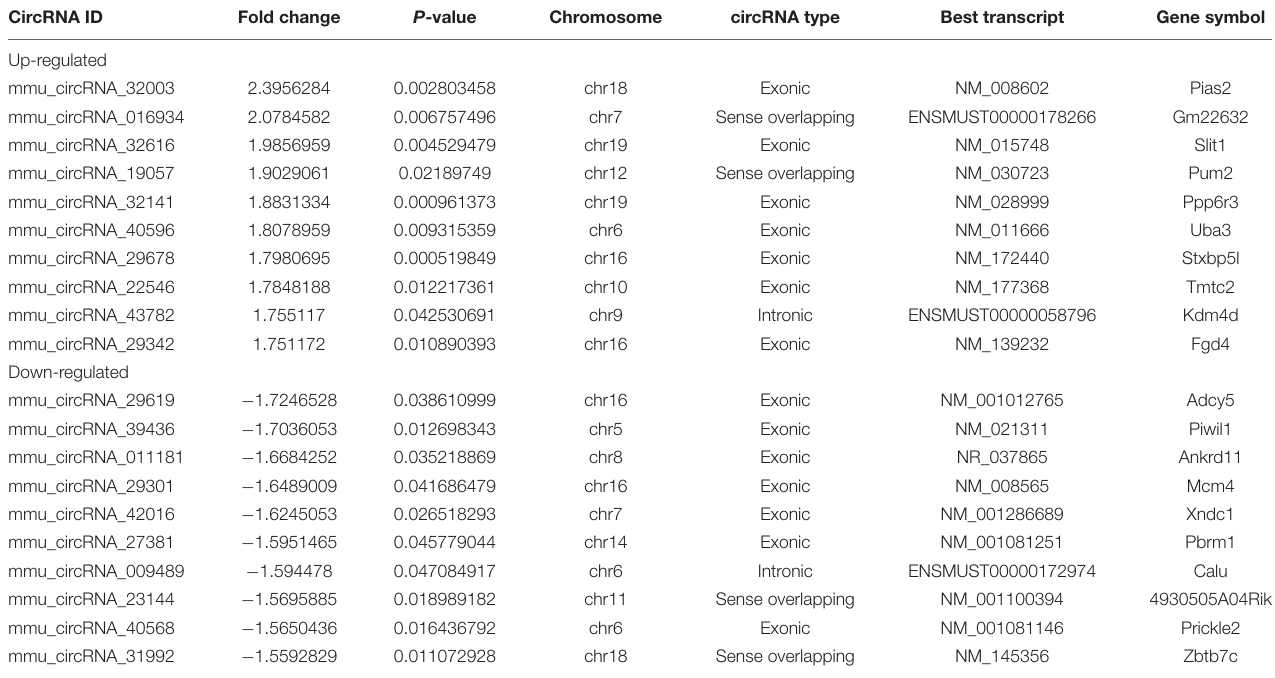
TABLE 2 | Biological information for the top 10 upregulated and downregulated circRNAs. CircRNA ID Fold change P -value